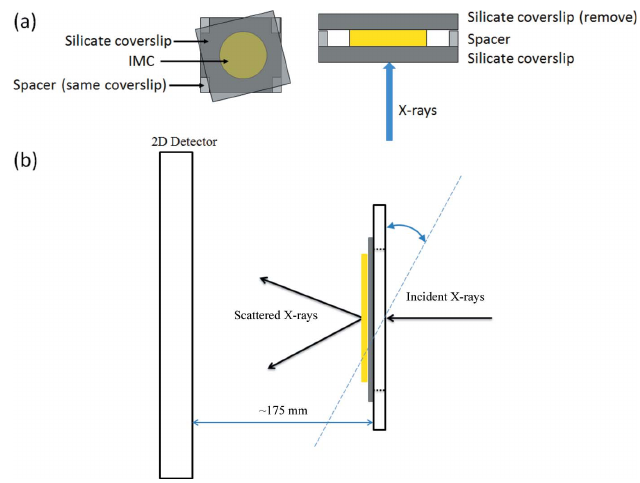
Figure 1 ( a ) Preparation of an IMC thin film. ( b ) Experimental setup for thin-film X-ray scattering measurements in transmission. The sample can be rotated if